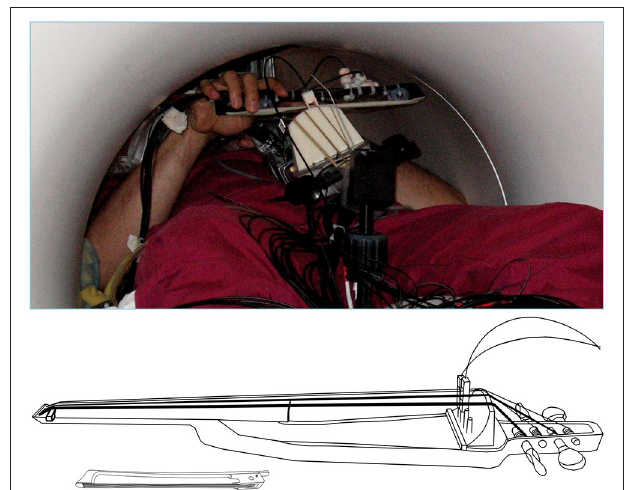
FIGURE 2 | (Top) View of the MR-compatible cello and bow inside the scanner during experiment. (Bottom) Line drawing of cello and bow developed for use inside the MR Scanner. Cello fingerboard has the same dimensions as a fullsized cello to preserve the location and spacing of notes. Optic sensors at the bridge are used to detect string vibrations, and are converted to analog audio output by a custom ARM board (not shown). The MR Compatible bow is 20 cm long, which is just under a third of the length of a typical cello bow (approximately 70